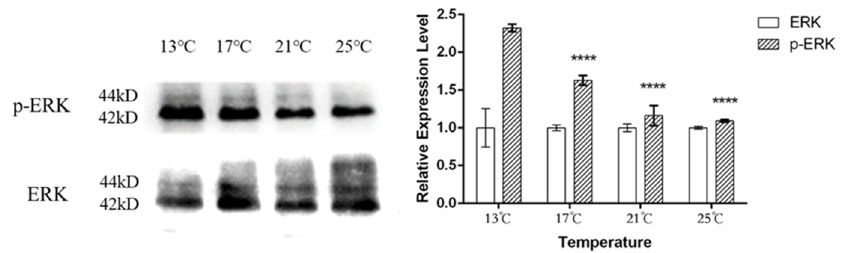
Figure 9. The phosphorylation of ERK decreased with an increase in temperature at 48 h. Data represent mean ± standard errors ( n = 3). **** p < 0.0001, vs. 13 °C. To verify the involvement of ERK signaling pathway in cellular functions of N. yezoen- sis , we added the ERK inhibitor FR 180204 to the seawater in which the protoplasts were